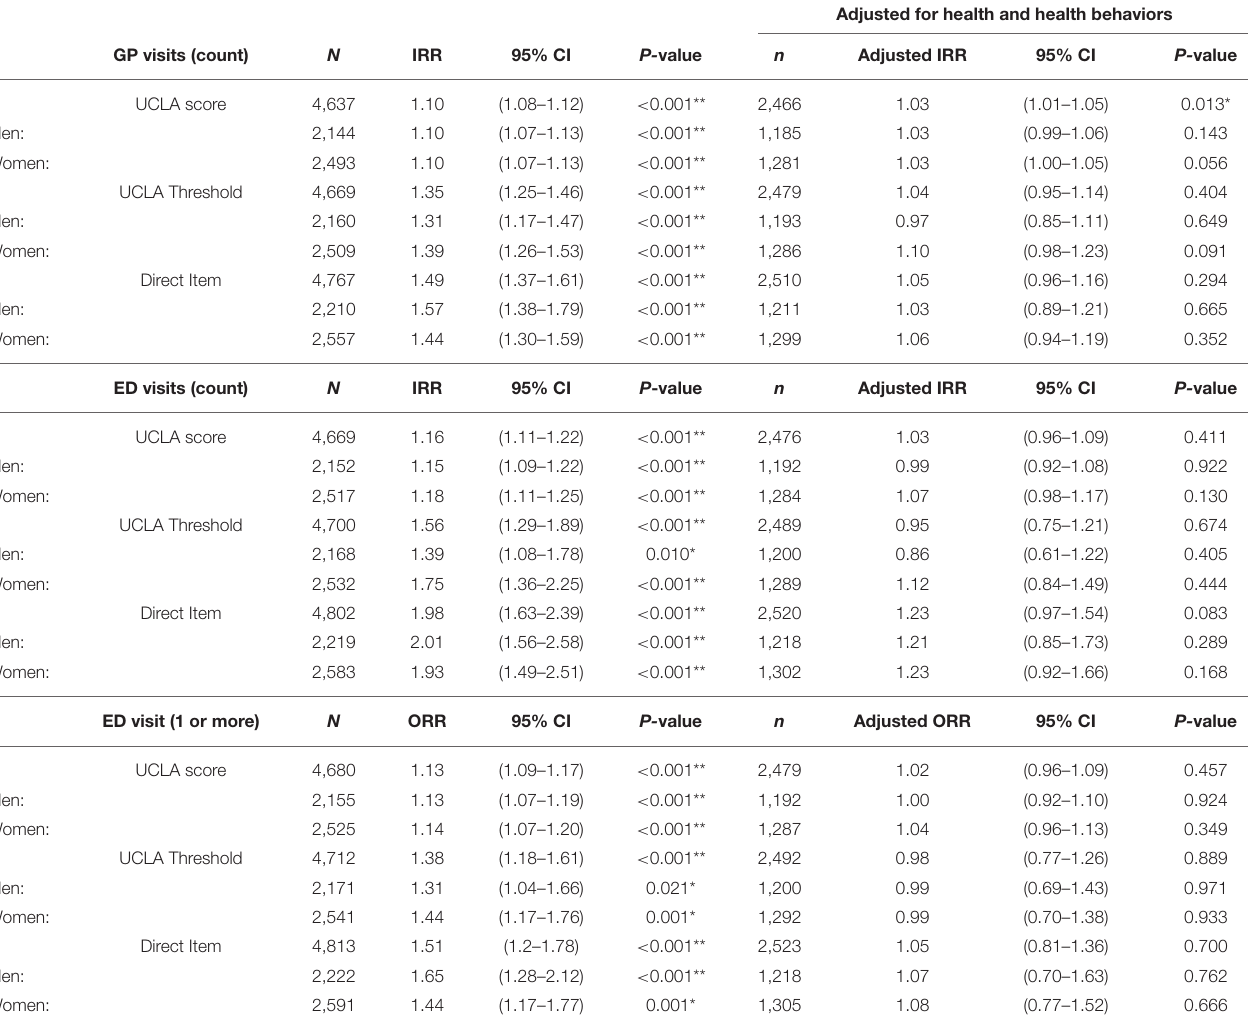
TABLE 2 | Associations between loneliness and HCU including adjustment for health and health behaviors.